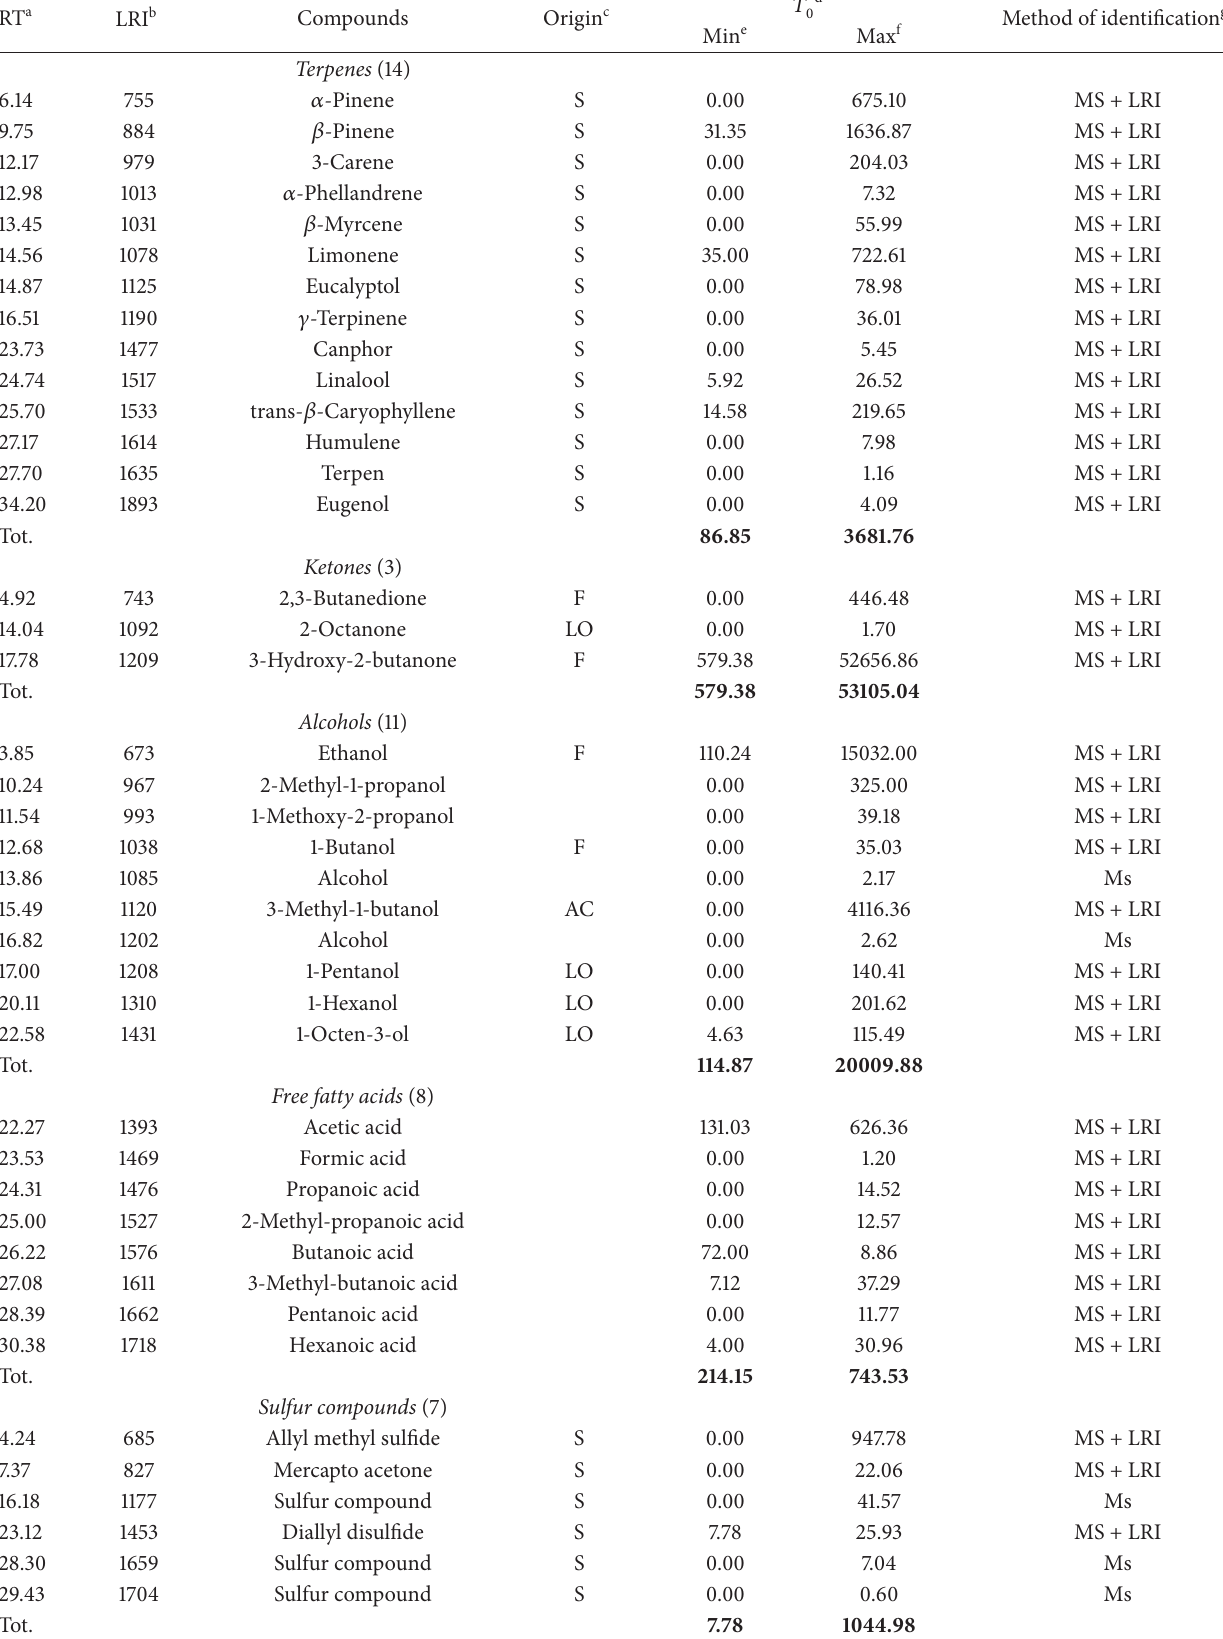
Table 6: Volatile compounds detected in “Salamini di Mandrogne” salami (ngg − 1